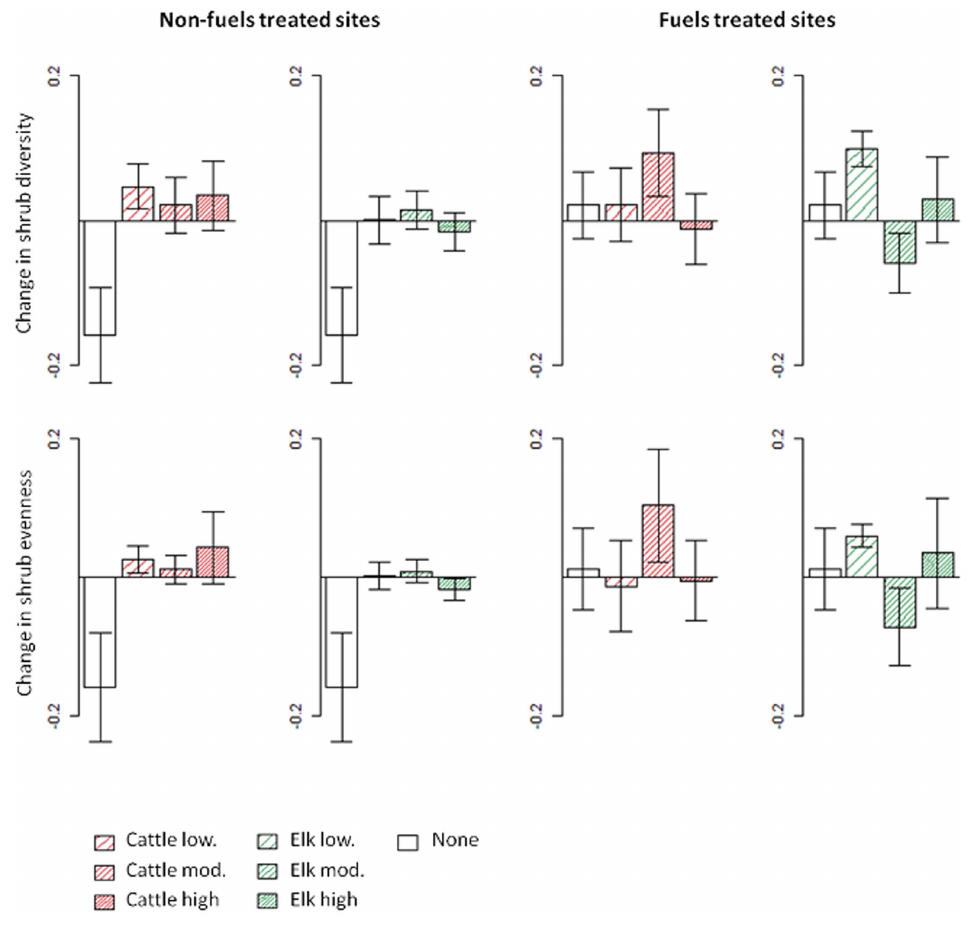
Figure 4. Change in shrub species diversity and evenness from the year prior to browsing initiation to six years after at non-fuels treated and fuels treated forest sites. Mean and standard error of paddocks under different levels of browsing pressure (low, mod., high) by cattle and elk is compared to mean and standard error of un-browsed paddocks (none).